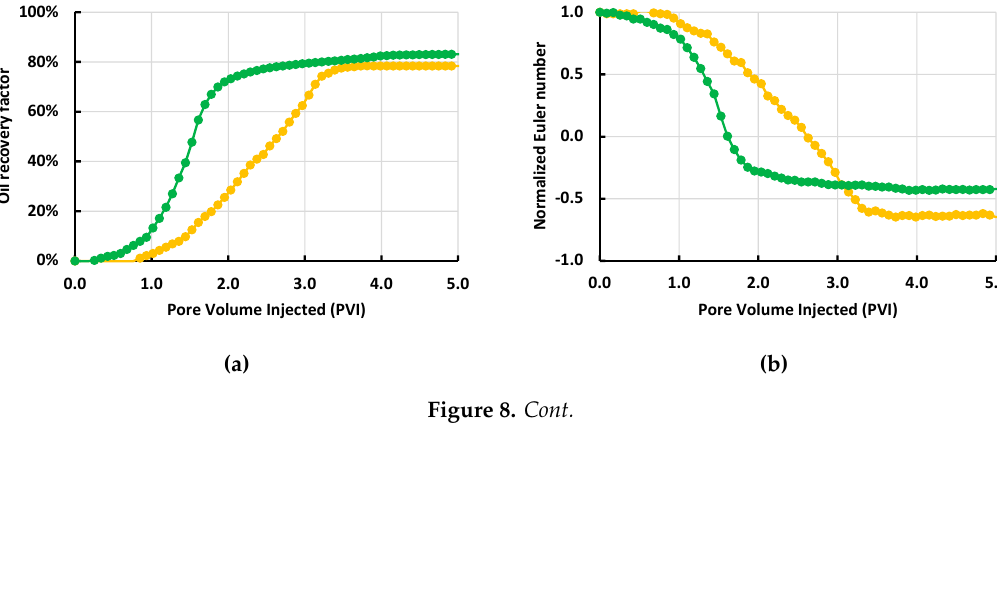
(f) Figure 8. Microfluidic results showing the effect of a higher flow rate (0.39 µL/min) on the recovery performance: ( a ) Oil recovery factor; ( b ) Normalized Euler number; ( c ) Number of clusters; ( d ) Normalized cumulative oil volume; ( e ) Differential pressure; ( f ) Injectivity index. 4. Discussion 4.1. Performance of the Xanthan Gum and Scleroglucan The performance of the solutions used in this study was evaluated comparing the reference fluids (Brine and NF) and the biopolymer solutions with NPs. In this way, were tested the main properties of the polymers and NPs. The main objective of adding polymers to the brine was to increase the viscosity to improve the sweep efficiency of the water flooding. Table 7 showed an increase of more than two times the viscosity of the biopolymer solutions in comparison with the brine. Additionally, the interaction with the Silica NPs increased this measure in 0.1 mPa·s in the Scleroglucan and the reference fluid (NF). In the xanthan gum solutions, the NPs reduced the viscosity in 0.1 mPa·s. However, no evidence of relevant polymer degradation was shown when the NPs were added to the polymer solution.